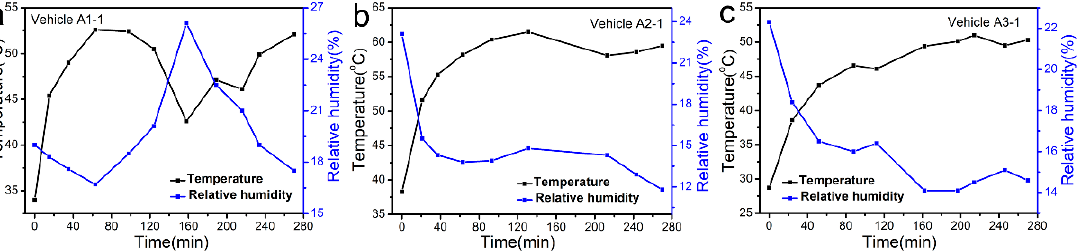
Figure 1. The changes in temperature and relative humidity in sunny conditions inside the vehicles of ( a ) A1-1, ( b ) A2-1 and ( c ) A3-1 during enclosure and air sampling. of ( a ) A1-1, ( b ) A2-1 and ( c ) A3-1 during enclosure and air